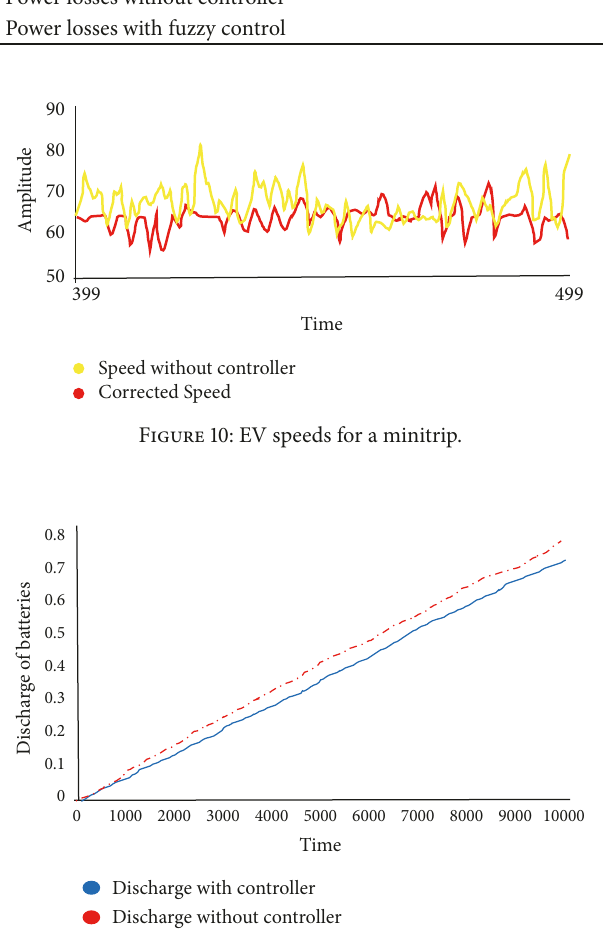
Figure 11: Discharge time of the EV battery